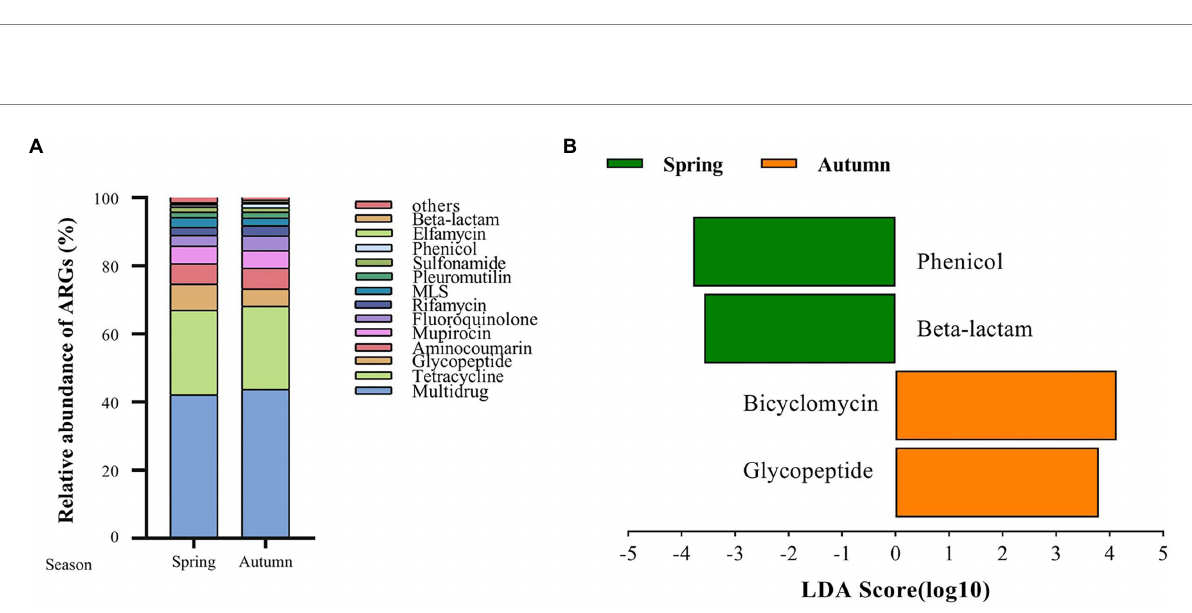
FIGURE 8 Fungal antibiotic resistance genes (ARGs) in AS phyllosphere. Relative abundance of fungal antibiotic resistance genes (ARGs) in AS phyllosphere between spring and autumn (A) . LEfSe analysis of fungal antibiotic resistance genes (ARGs) in AS phyllosphere between spring and autumn (B) . (LDA score ≥